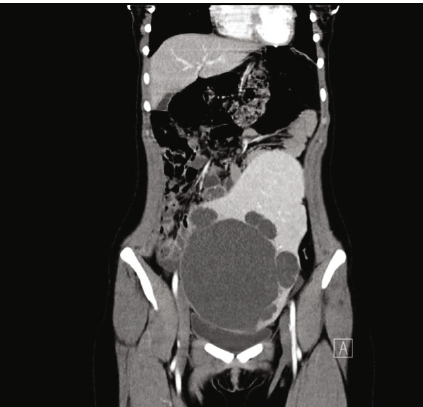
Figure 1: Coronal plane CT image of large intra-abdominal wandering spleen with cystic masses.